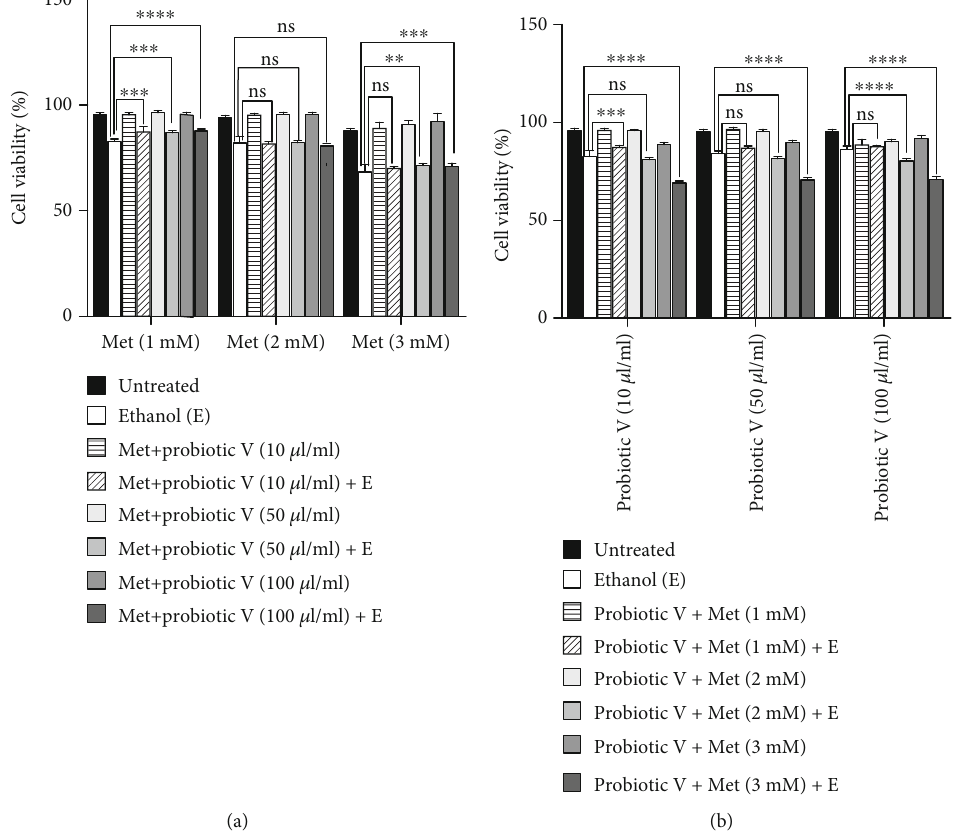
Figure 1: E ff ect of probiotic V and Met on the viability of HepG2 cells. (a) HepG2 cells were exposed to 100 mM ethanol and cotreated with probiotic V (10, 50, and 100 μ l/ml) and Met (1, 2, and 3 mM) in di ff erent combinations and compared with the individual doses of Met 1, 2, and 3mM alone in the presence of ethanol (ethanol column in the graph) for 48 h; (b) HepG2 cells were exposed to 100mM ethanol and cotreated with probiotic V (10, 50, and 100 μ l/ml) and Met (1, 2, and 3 mM) in di ff erent combinations and compared with the individual doses of probiotic V (10, 50, and 100 μ l/ml) alone in the presence of ethanol (ethanol column in the graph) for 48h. The average percentage of cell viability after respective treatment was analyzed through MTT assay. Values represent the mean ± SD of three individual experiments. Statistical signi fi cance was assessed by one-way ANOVA followed by Tukey post hoc test. Statistical analysis: #### p < 0 : 0001 compared with control group; ∗∗ p < 0 : 01 , ∗∗∗ p < 0 : 001 , and ∗∗∗∗ p < 0 : 0001 compared with ethanol group as well as individual treatment of probiotic V (10, 50, and 100 μ l/ml) and Met (1, 2, and 3mM) groups in di ff erent combinations; ns stands for nonsigni fi